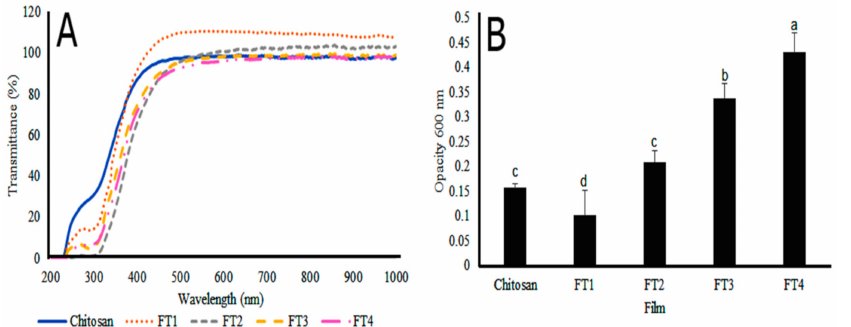
Figure 9. Transmittance ( A ) and opacity ( B ) of films made with pure chitosan and the hybrid films FT1-FT4 containing different concentrations of TvEO. Bars with diverse letters indicate statistically significant differences ( p < 0.01) by ANOVA-Tukey test.